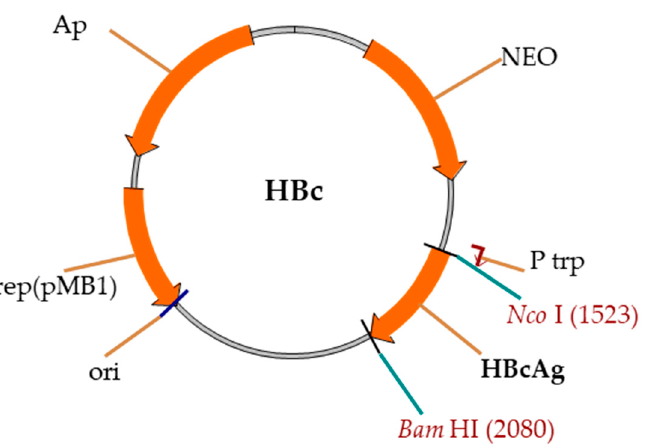
Figure 2. Schema of the pBR327-based vector for the expression of HBc genes. Rep(pMB1)—ori re- gion, Ap—gene for Ap resistance, NEO—gene for neomycin–kanamycin resistance, Ptrp—E. coli Ptrp-promoter, and HBc—HBc gene.